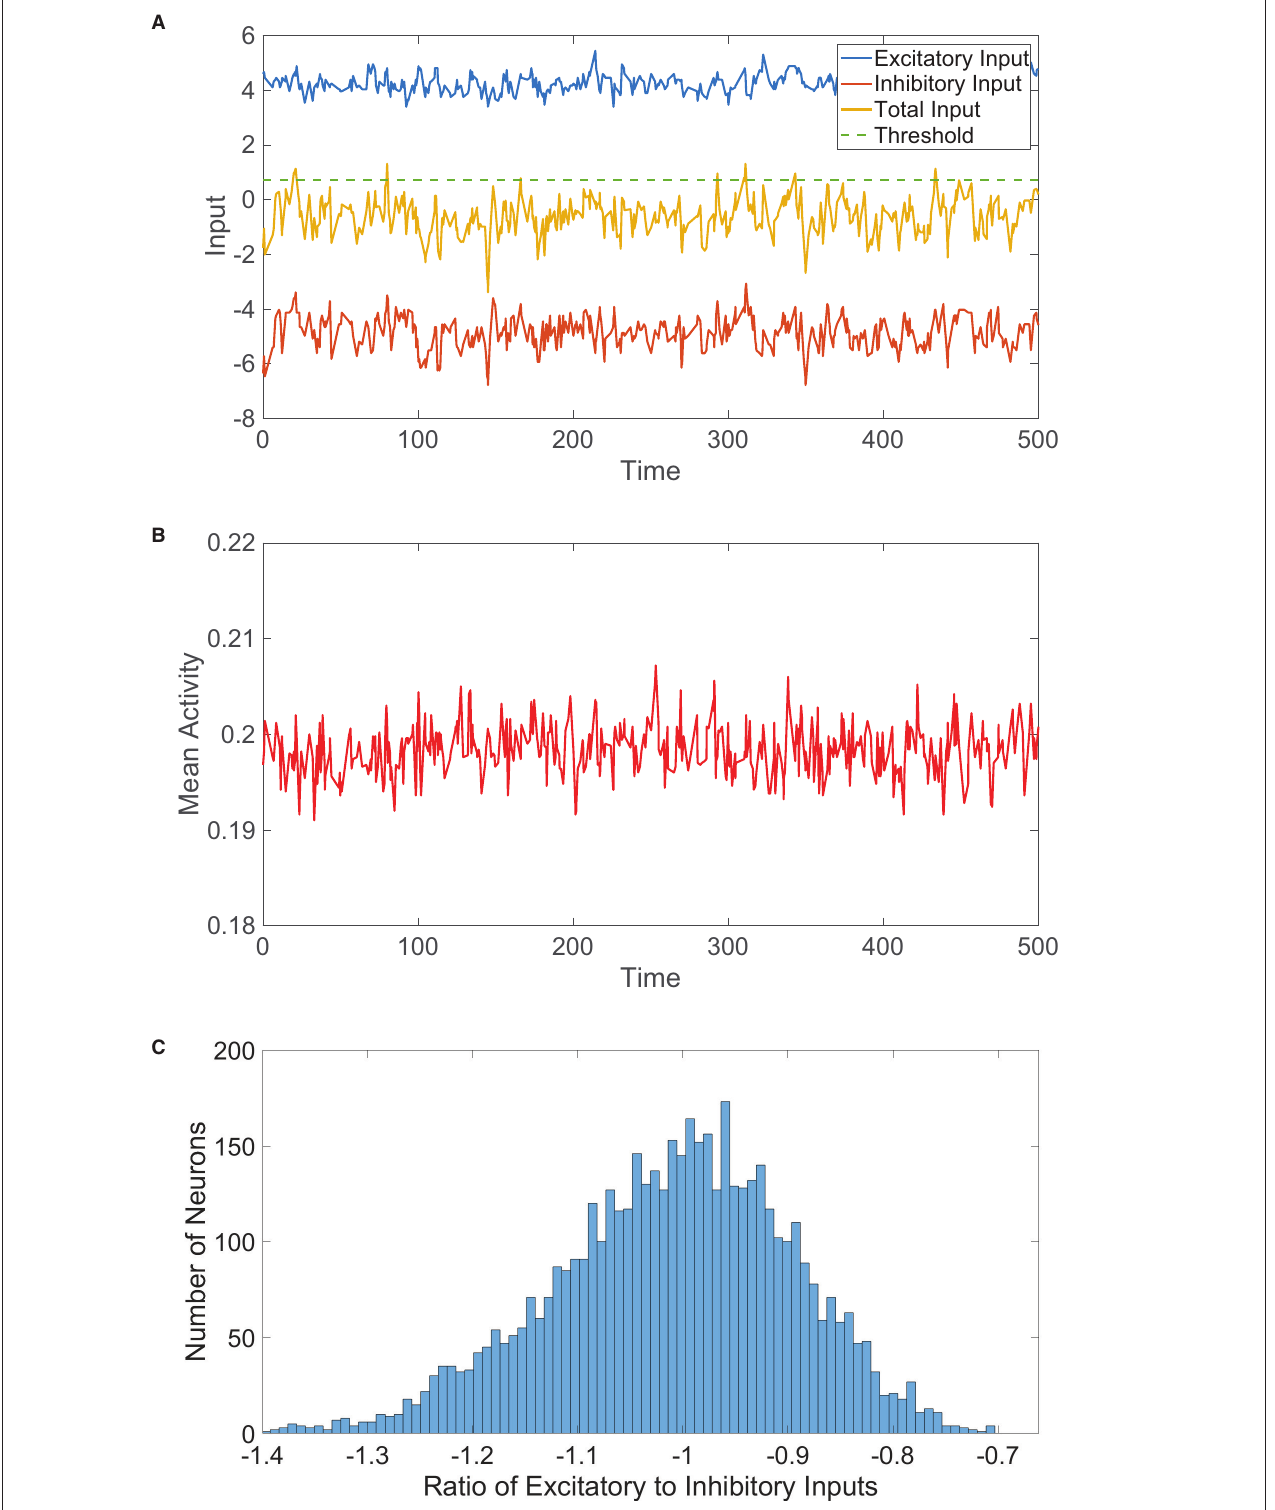
FIGURE 2 | One-population balanced network dynamics. (A) Excitatory (blue), inhibitory (red), and net (yellow) inputs into a sample neuron in a one-population balanced network. The dashed (green) line indicates the firing threshold. (B) The population-averaged state (mean activity) of the single population as a function of time. (C) Histogram of the ratio between time-averaged excitatory and inhibitory inputs across the one-population neuronal network. In evolving the state of each neuron in the one-population network, the mean time between subsequent updates is τ 10 ms unless stated otherwise. Parameters utilized are = J E 1, J I 1.5, N 5,000, f E 0.5, m 0 0.2, K 200, and θ = = = = = = =